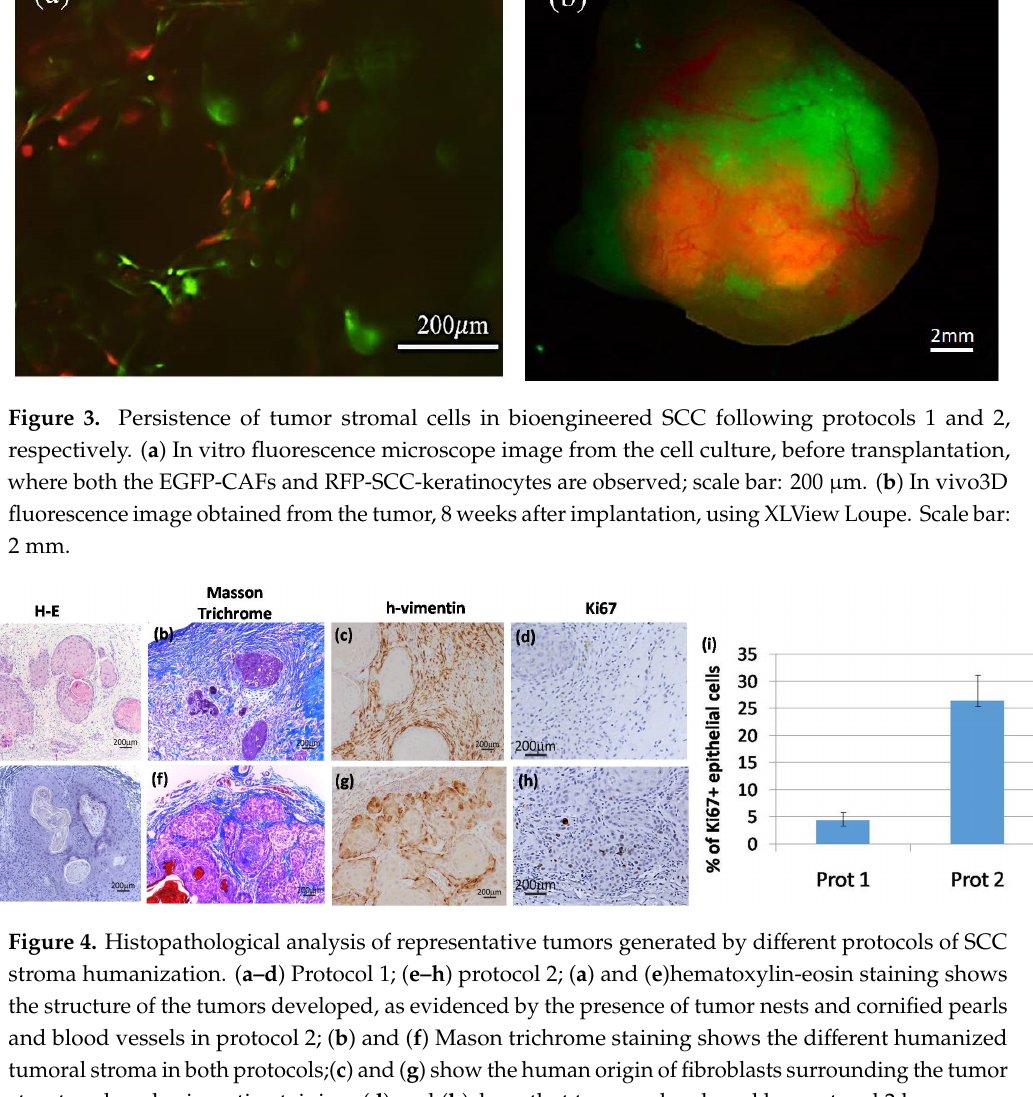
Figure 2. Macroscopic characterization of tumors developed in the presence of humanized stroma after 8 weeks of transplantation. ( a ) Tumor developed by protocol 1; ( b ) tumor developed by protocol2.